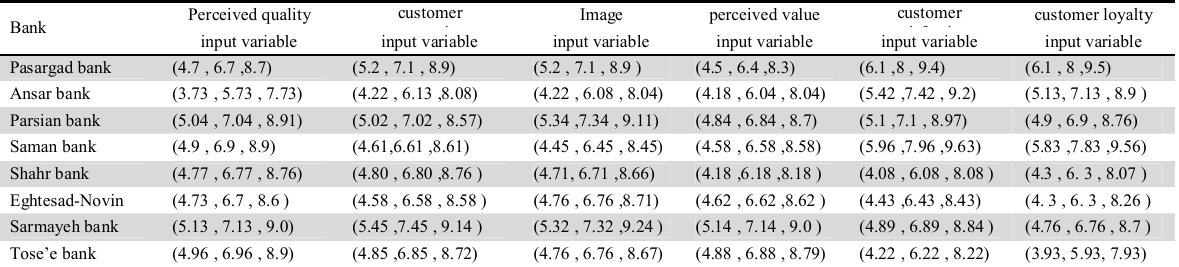
Fuzzy average of input and output variables values in output-orientated CCR